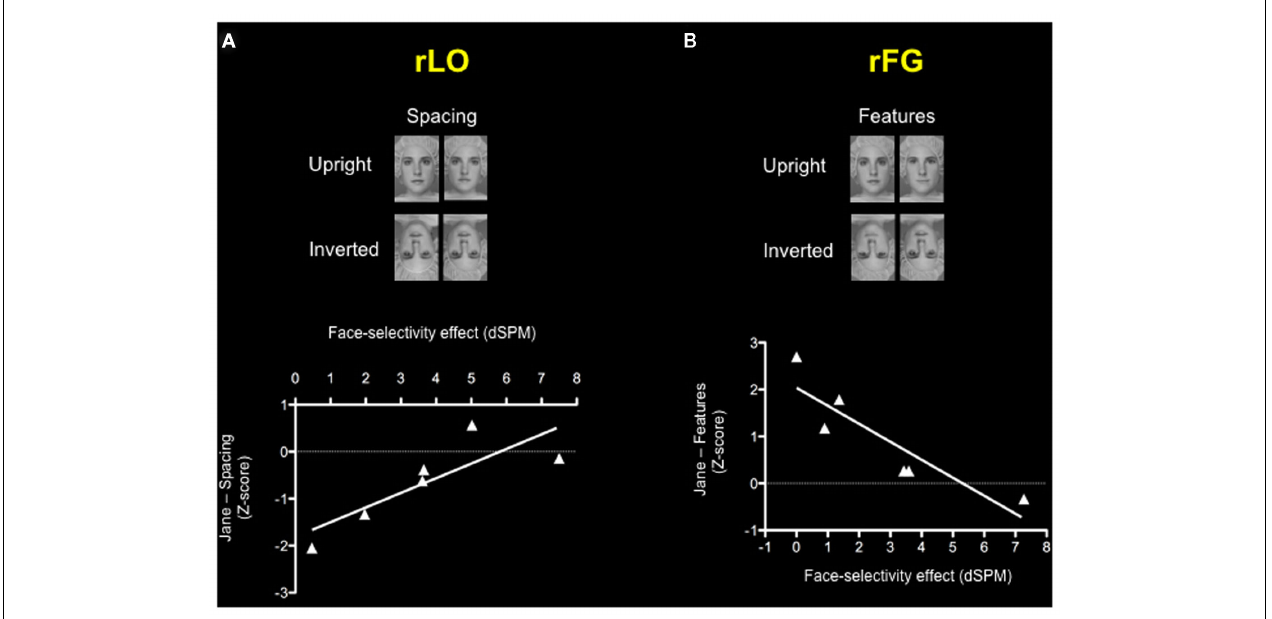
subset of the Jane task within rLO and (B) negative correlation between the face-selectivity of the M170 and inversion effect on the features subset of the Jane task within rFG, indicating how the M170 codes different processing according to the locus of its